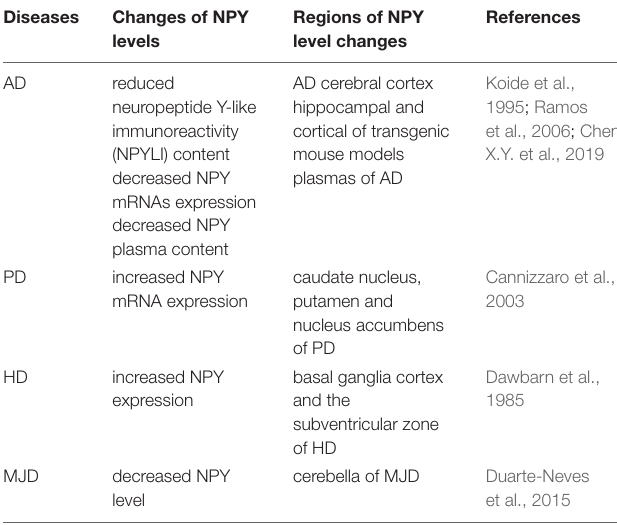
TABLE 2 | Alteration of NPY levels in neurodegenerative